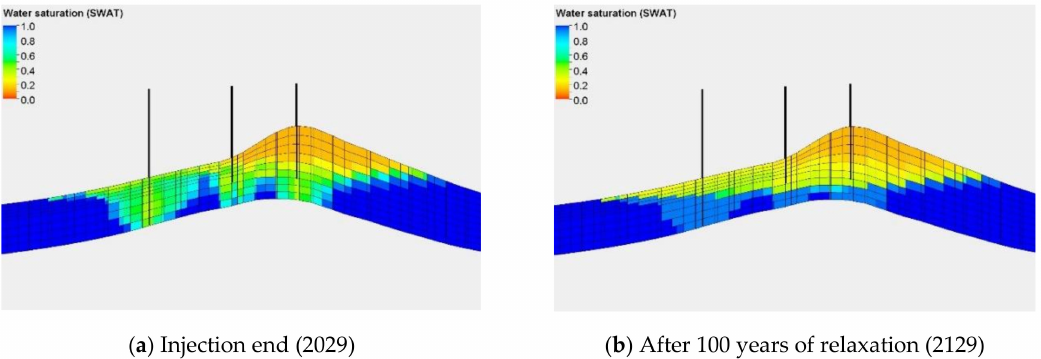
Figure 48. Distribution of brine saturation along the vertical cross section